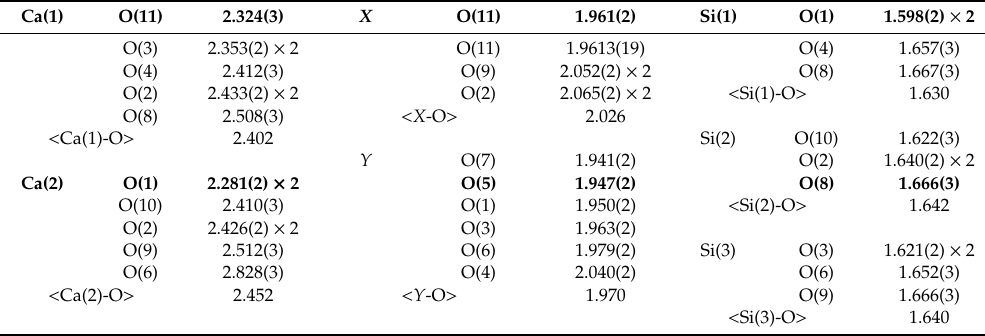
Table 5. Selected interatomic distances (Å) in the structure of shuiskite-(Cr).